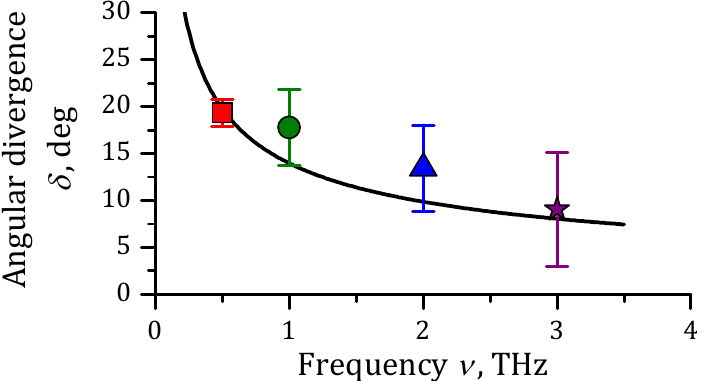
Figure 4. Dependence of the angular divergence δ of THz radiation on frequency ν estimated from angular distributions of THz fluence F ( θ ) (symbols). Black solid curve shows the fit of the angular divergence by Equation (1). Symbols correspond to the ones in Figure